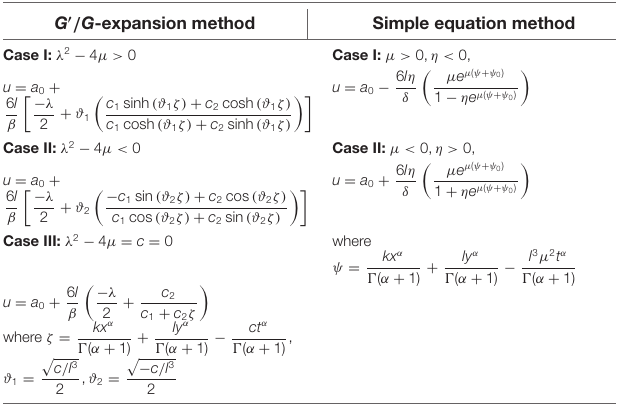
TABLE 1 | Solutions comparison of the non-linear space-time frational Estevez-Mansfield-Clarkson (EMC) equation between G ′ / G -expansion method and simple equation (SE) method.